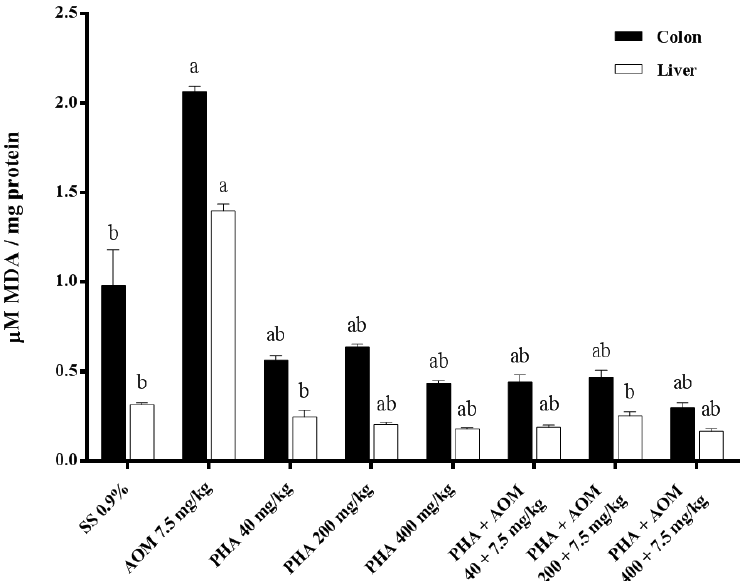
Figure 2. Effect of phaseolin (PHA) on the content of malondialdehyde (MDA) in the colon and liver of mice administered azoxymethane (AOM). Each bar represents the mean ± SEM obtained from six mice per group. a Statistically significant difference with respect to the saline solution (SS) control group, and b with respect to the AOM-treated group. ANOVA and Holm-Šídák tests, p < 0.05.